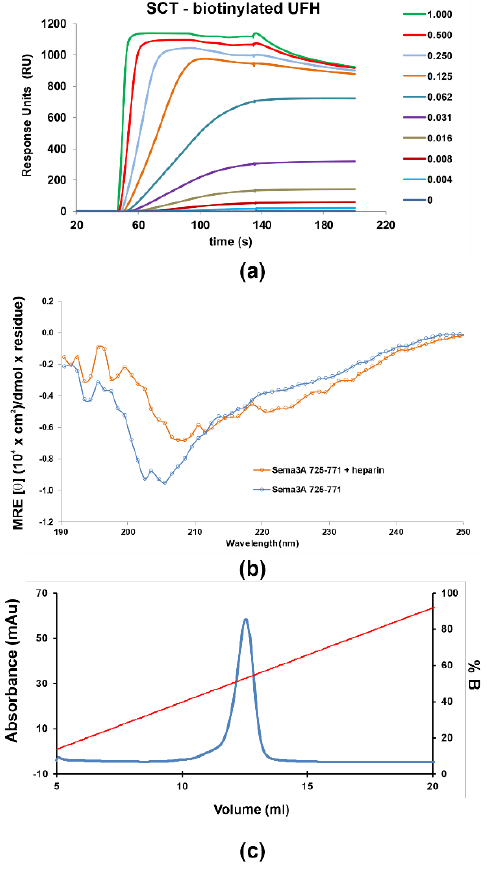
Figure 3. SPR sensorgrams of increasing amounts (0 to 1 μM) of the SCT WT construct flown over (HBS-T buffer) ( a ) immobilized biotinylated heparin (350 RU) ( b ) CD Spectra of 5 μM Sema3A C-terminal region in the absence (blue) and the presence of 1 μM UFH (orange), measured at pH 5.5 in 10 mM NaP. ( c ) Heparin sepharose affinity chromatography profile of SCT WT, with a single peak eluting in ~1.06 M NaCl. SCT WT was loaded onto a HiTrap Heparin column equilibrated with 15 mM Tris.HCl (pH 7.5), and eluted with a linear gradient to 2 M NaCl. Left ordinate axis, absorbance; righ ordinate axis, % NaCl (% B).